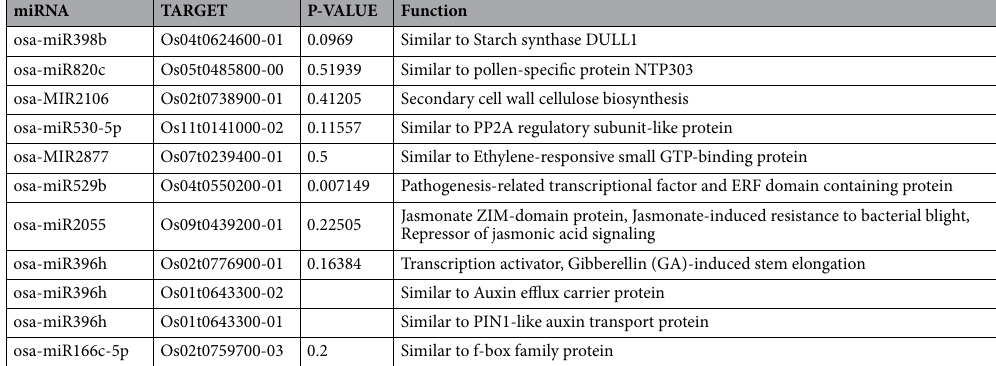
Table 2. Selected miRNAs for which qRT-PCR analysis was performed and searched for the target genes in the psRNA target server database. The most prominent targets of miRNAs, their p-values and important functions are